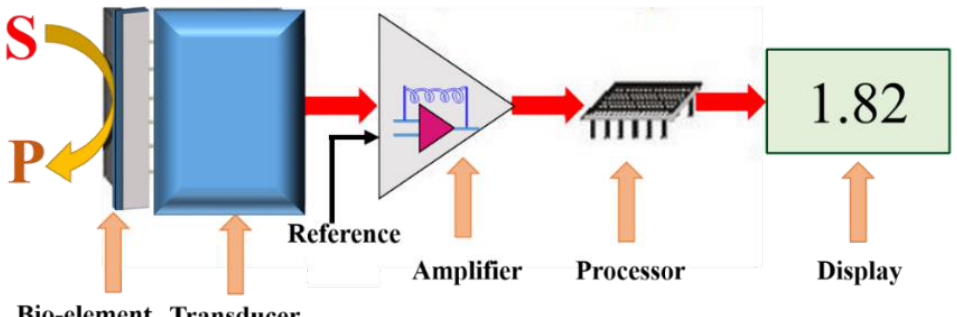
Figure 1. Schematic and working principle of a biosensor used to measure the conversion of a substrate (S) to a product (P) on a bio-element surface.